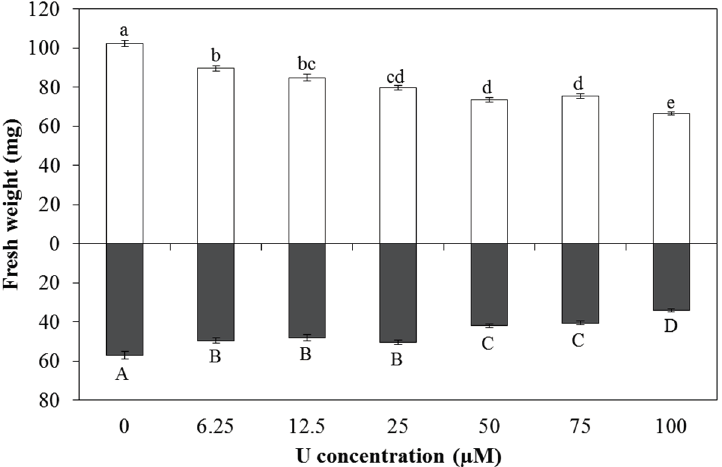
Figure 2. Fresh weight (mg per plant) of roots (grey bars) and leaves (white bars) of Arabidopsis thaliana plants exposed to different U concentrations for three days at pH 7.5. Statistical analyses were done separately for leaves and roots. Values represent the mean ± S.E. of at least 100 biological replicates. Data points with different letters are significantly different ( p < 0.05).